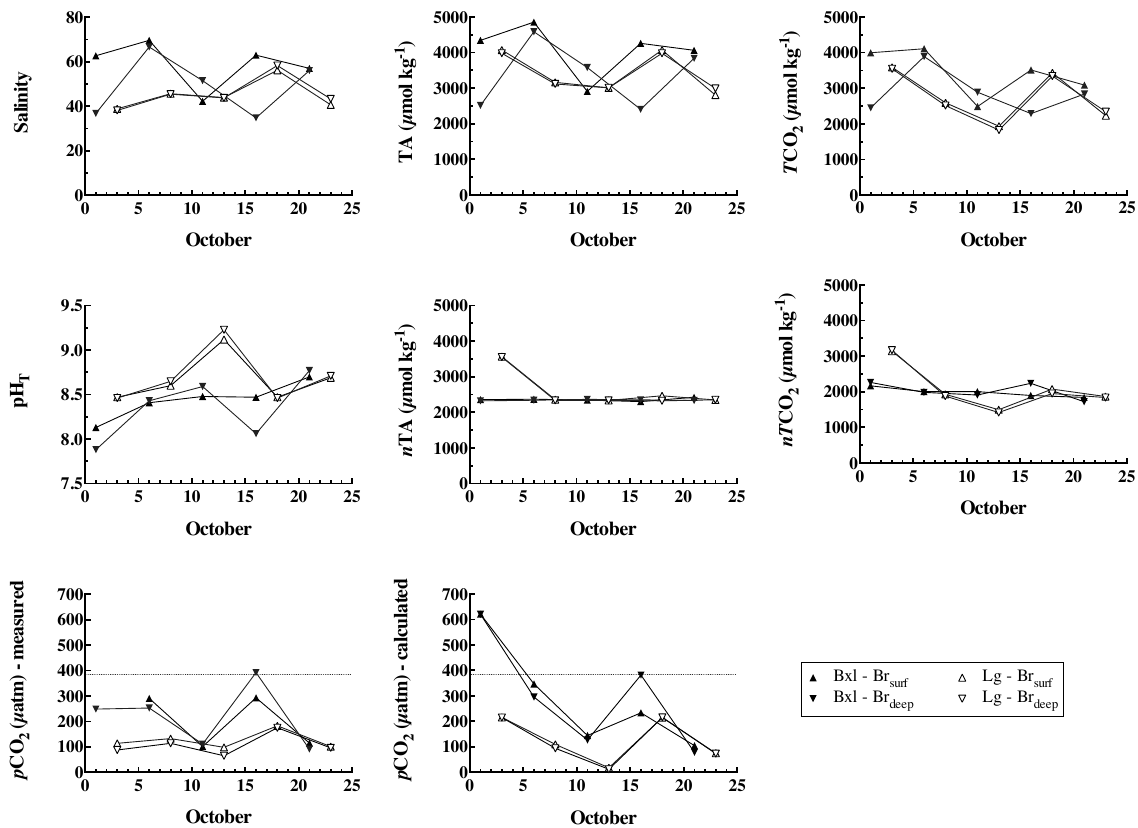
Figure 5. Evolution of salinity, pH T , TA (in µmolkg − 1 ), n TA (TA normalized to a salinity of 34, in µmolkg − 1 ), calculated T CO 2 (in µmolkg − 1 ) and nT CO 2 ( T CO 2 normalized to a salinity of 34, in µmolkg − 1 ), and measured and calculated p CO 2 (in µatm) in surface and deep brine sackholes from the Brussels (Bxl) and Liège (Lg) sites. The dotted line represents the atmospheric p CO 2 in October